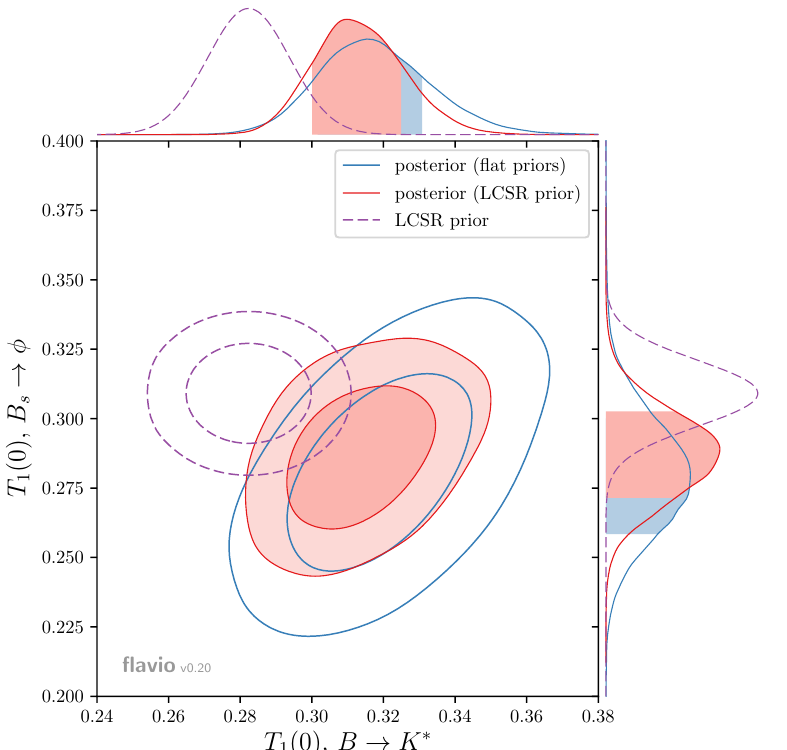
Figure 1 . Posterior probability distribution of the tensor form factors T B s (cid:30) transitions from two Bayesian (cid:12)ts to the three exclusive radiative branching ratios, assuming ! (cid:13)at priors (blue, empty contours) or the LCSR priors, (2.15) (red, (cid:12)lled contours). The dashed contours show the LCSR priors, (2.15), for comparison. Contours correspond to 68 : 3 and 95 : 5% posterior probability. The curves along the top and right axes show the one-dimensional marginal (posterior or prior) distributions for the individual form factors; the shaded bands correspond to 68 : 3% marginal